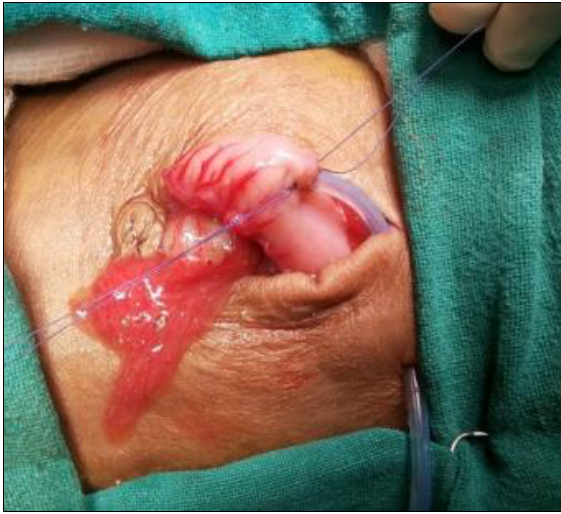
Figure 1: Tightening and tying of purse-string suture around gastrostomy tube.